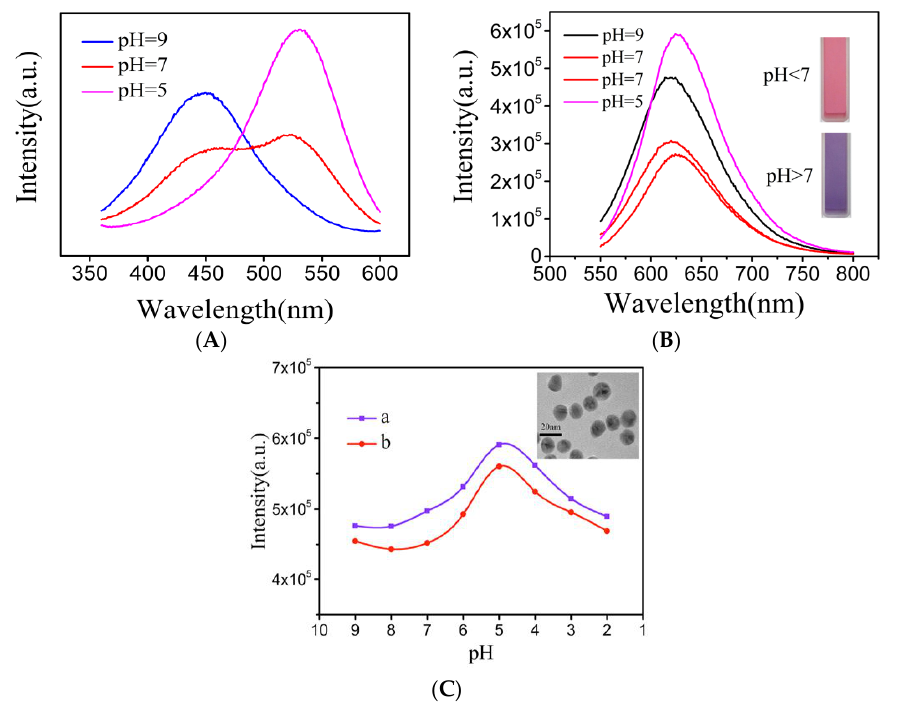
Figure 4. ( A ) Excitation spectra of the NR-β-CD@AuNPs at pH values of 9, 7, and 5; ( B ) Emission spectra of the NR-β-CD@AuNPs at pH values of 9, 7, and 5; ( C ) Fluorescence intensity of the